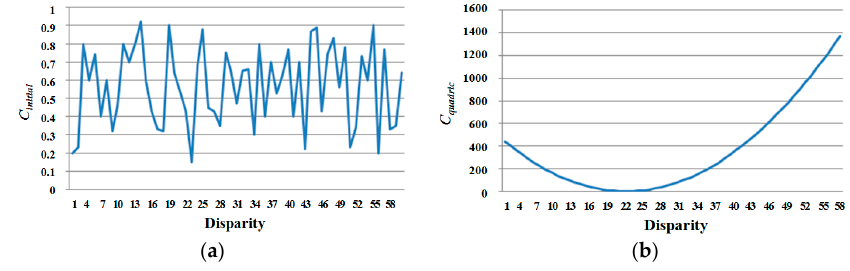
Figure 5. ( a ) Initial matching cost; ( b ) new quadric cost.